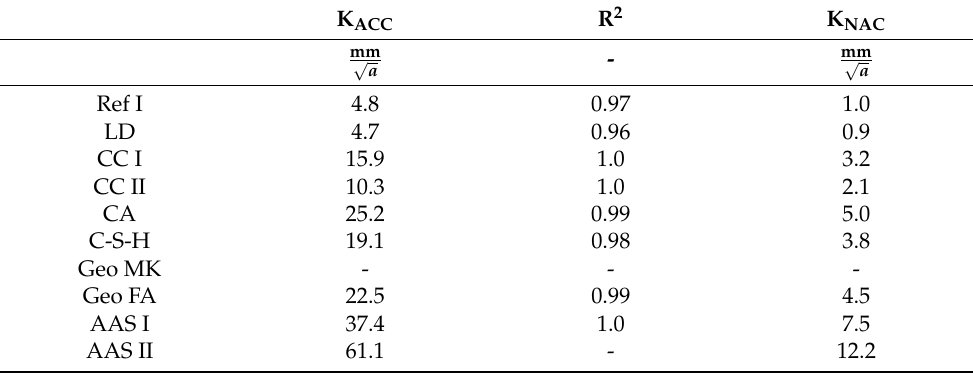
Figure 8. Carbonation depths at cement lime specimens over one year from accelerated test (1 vol.-% CO 2 ) and regression. Table 4. Carbonation coefficients for acc. carbonation (1 vol.-% CO 2 ), coefficient of determination and calculated carbonation coefficient for natural carbonation (400